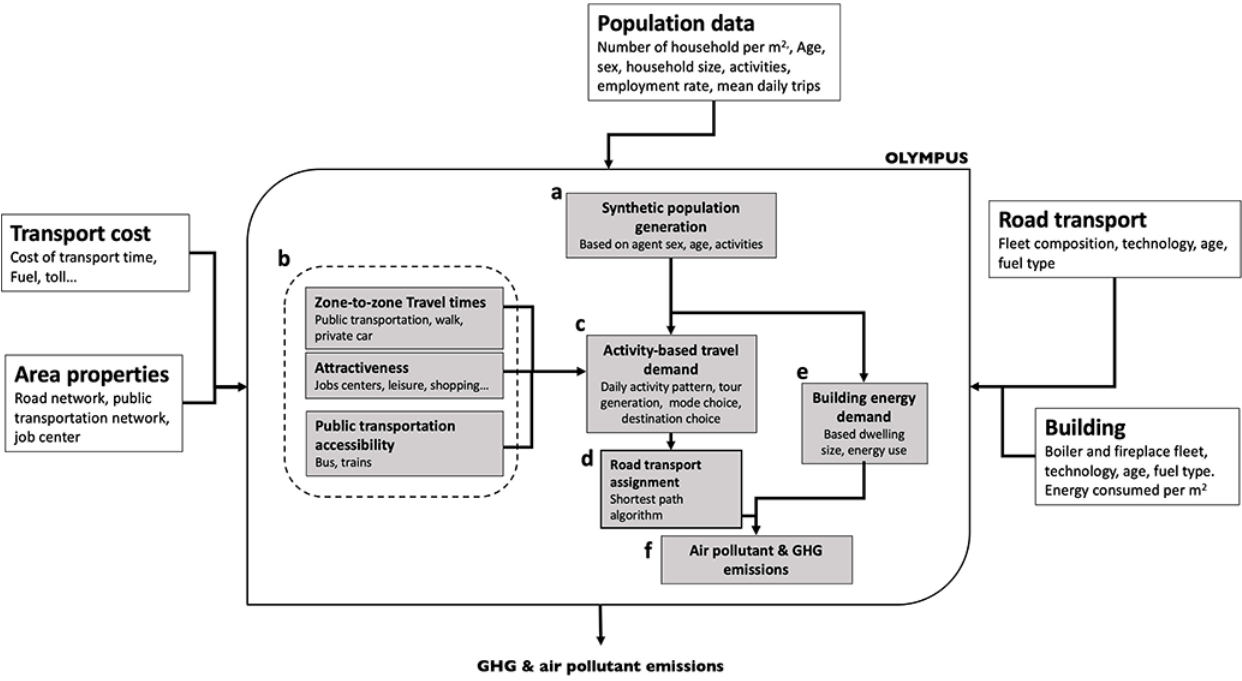
Figure 11. Schematic representation of OLYMPUS emission operating system (Elessa Etuman and Coll,